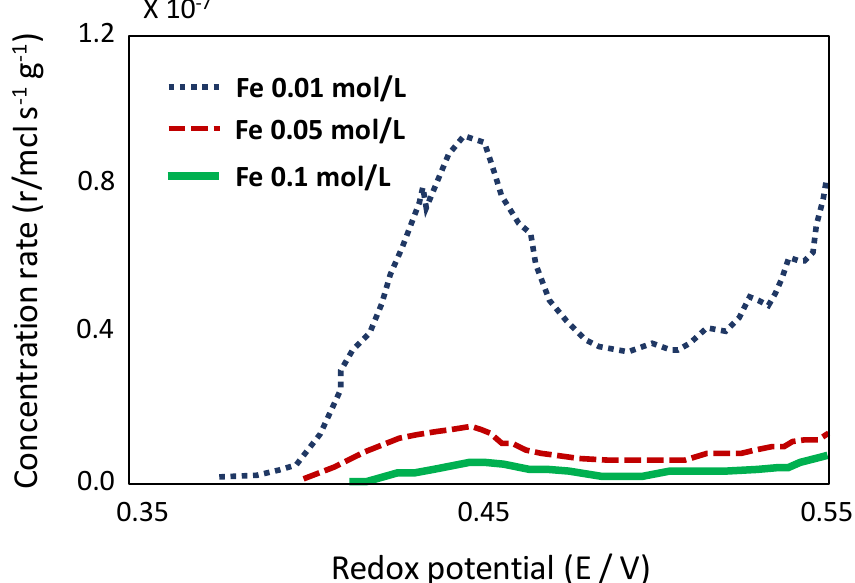
Figure 4. Effects of ferric ion concentration on the potential redox dependence of chalcopyrite leaching: copper extraction rate as a function of redox potential, temperature 343 K, HCl concentration 0.1 kmol m − 3 , initial Cu 2+ concentration of 0.01 kmol m − 3 , solid to liquid ratio of 0.3 g CuFeS 2 /15 mL and stirring speed of 400 rpm) (Modified from [58]).